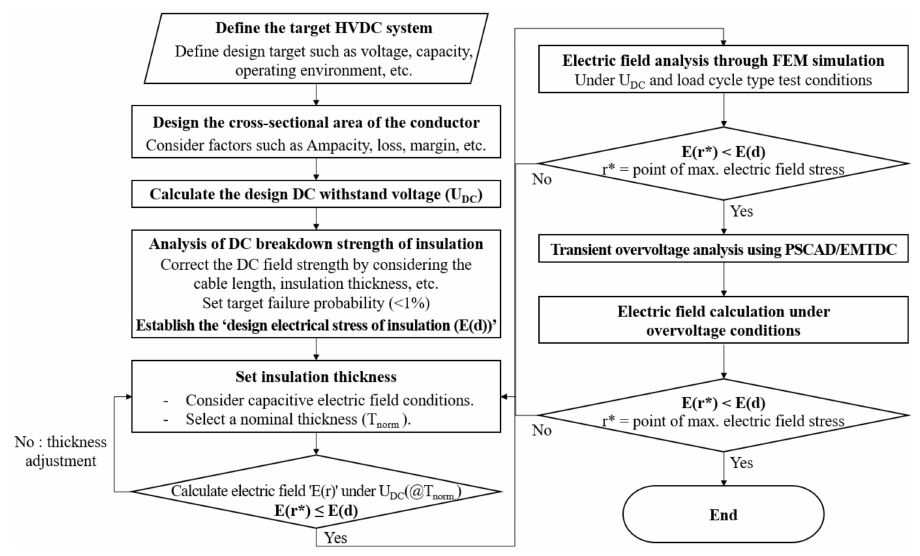
Figure 1. Design and verification processes for an HVDC cable